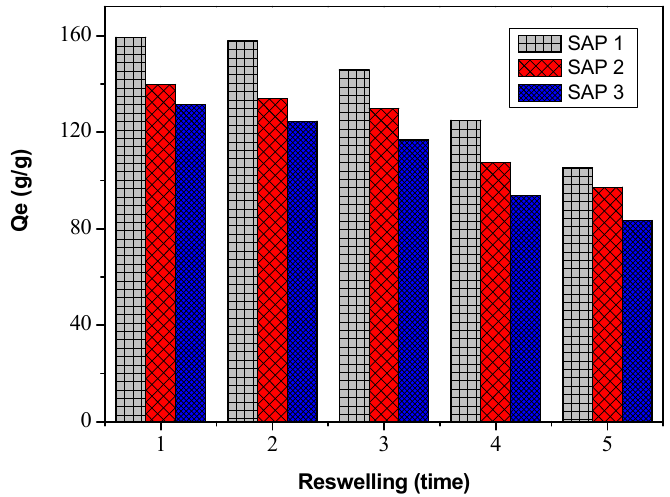
Figure 5. Superabsorbent